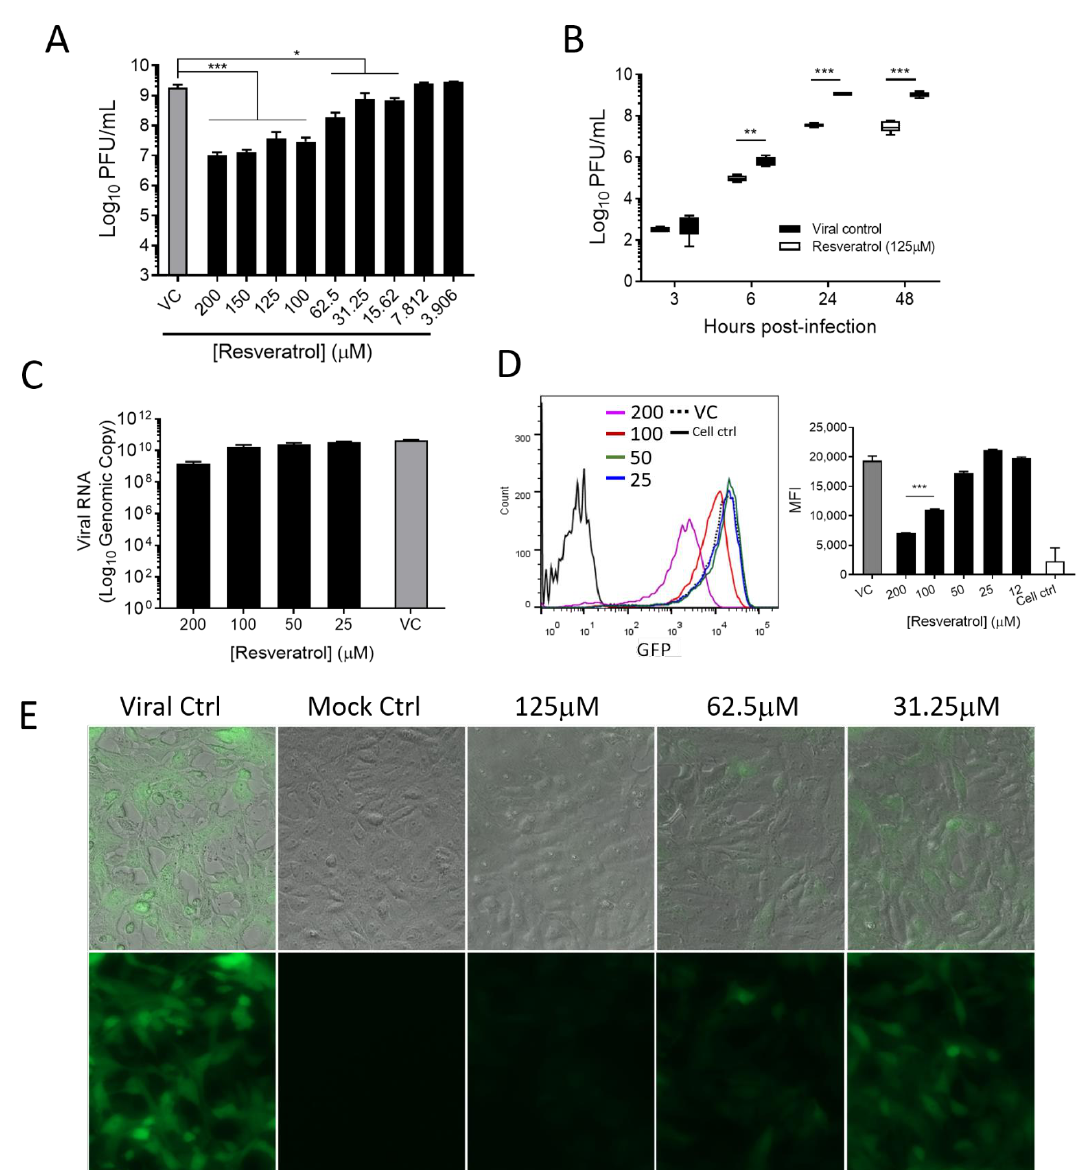
Figure 2. VEEV replication and propagation of infectious virions were assessed after resveratrol treatment. Supernatants from VEEV-TC-83-infected Vero cells (MOI = 0.1) were collected at ( A ) 16 hours post-infection (h.p.i.) with various concentrations of resveratrol and ( B ) at the indicated time points with 125 µ M of resveratrol, followed by performing plaque assays to measure viral titers. ( C ) Total cellular RNA was isolated from infected cells after 16 h of VEEV-TC83 infection (MOI of 0.1) followed by conducting RT-qPCR to quantify the viral RNA. ( D ) GFP-encoded VEEV-TC83 was used to quantify and visualize the VEEV-infected cells at 16 h.p.i. by ( D ) flow cytometry and ( E ) fluorescent microscopy. MFI, median of fluorescence intensity; VC, viral control. Data were expressed as means ± S.E.M. * p < 0.05; ** p < 0.01; *** p < 0.001 compared to viral control (VC) by one-way ANOVA.